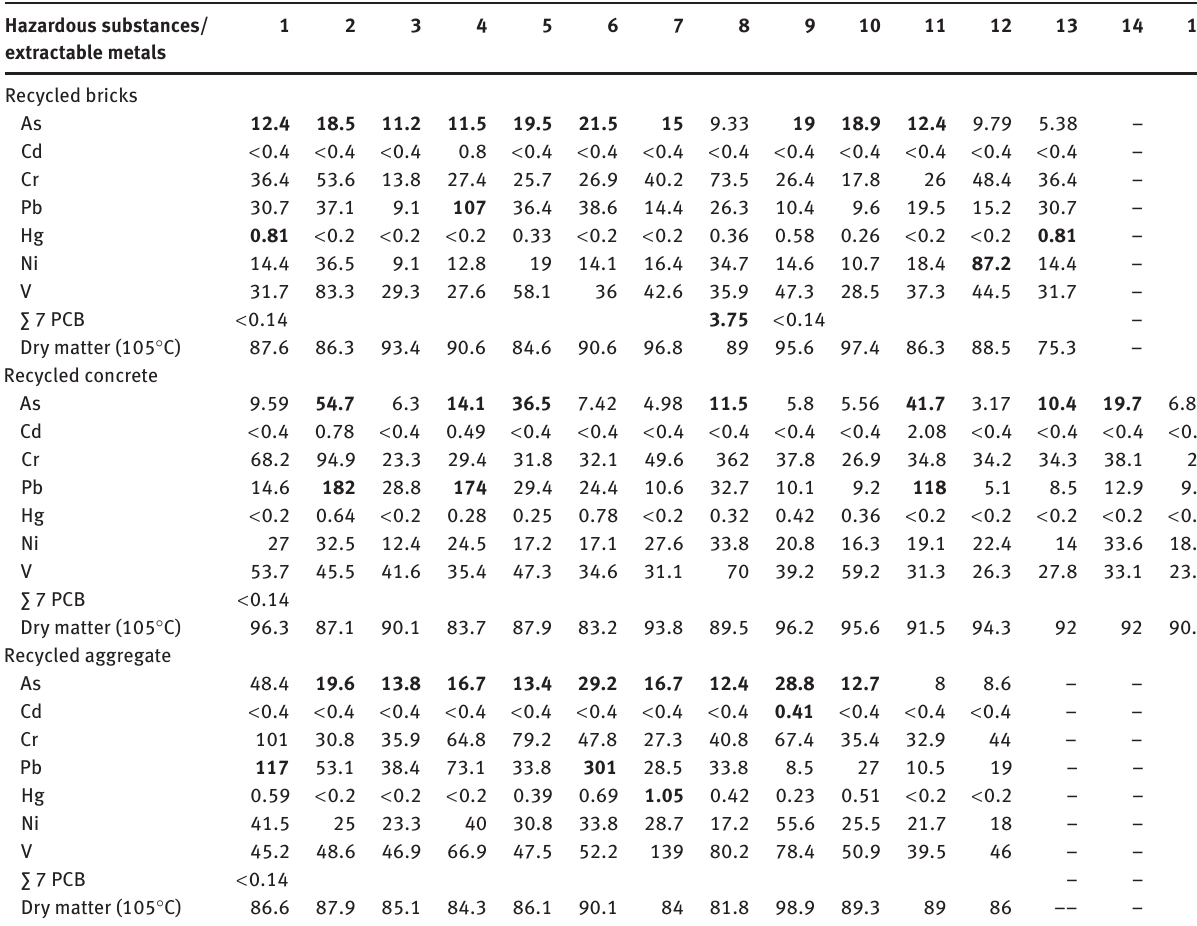
Table 4: Contents of hazardous